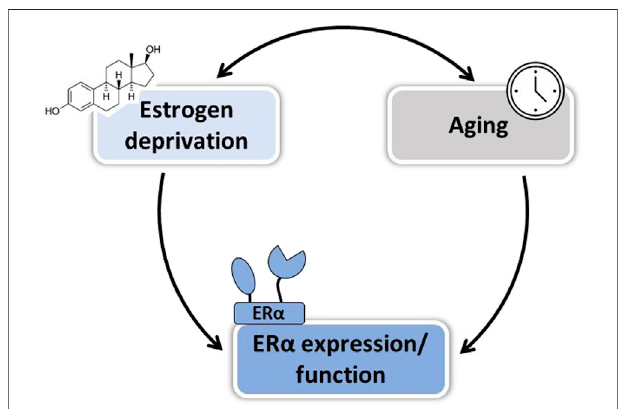
FIGURE 2 | Factors involved in the loss of E2 vascular protection after menopause. Both duration of estrogen deprivation and aging per se could contribute to the loss of E2-mediated vascular protection in postmenopausal women, in part by altering ER α expression and/or function.